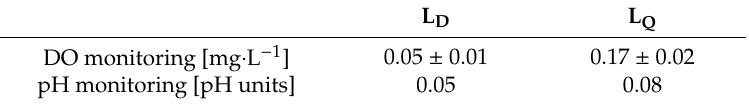
Table 1. L D and L Q for the measurement of DO and pH of the Nafion ® coated needle (n =